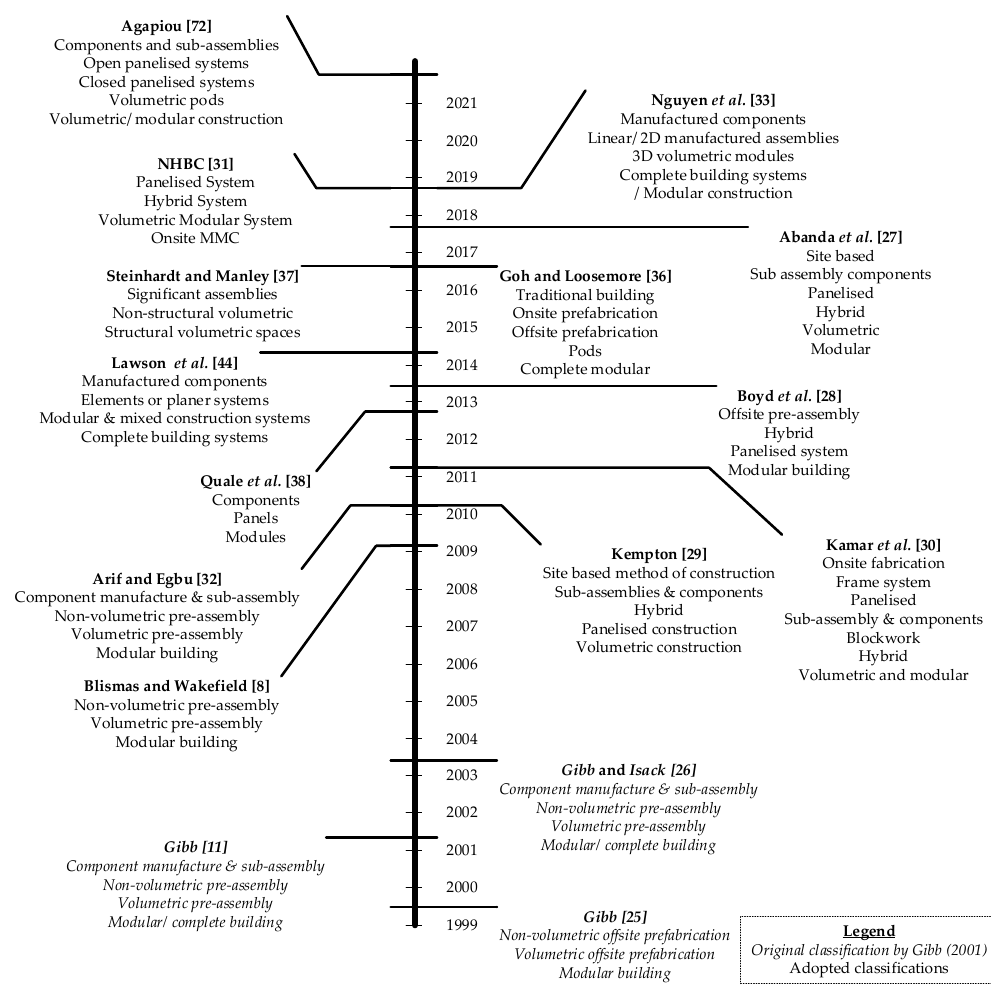
Figure 1. Chronology of OSC classifications.